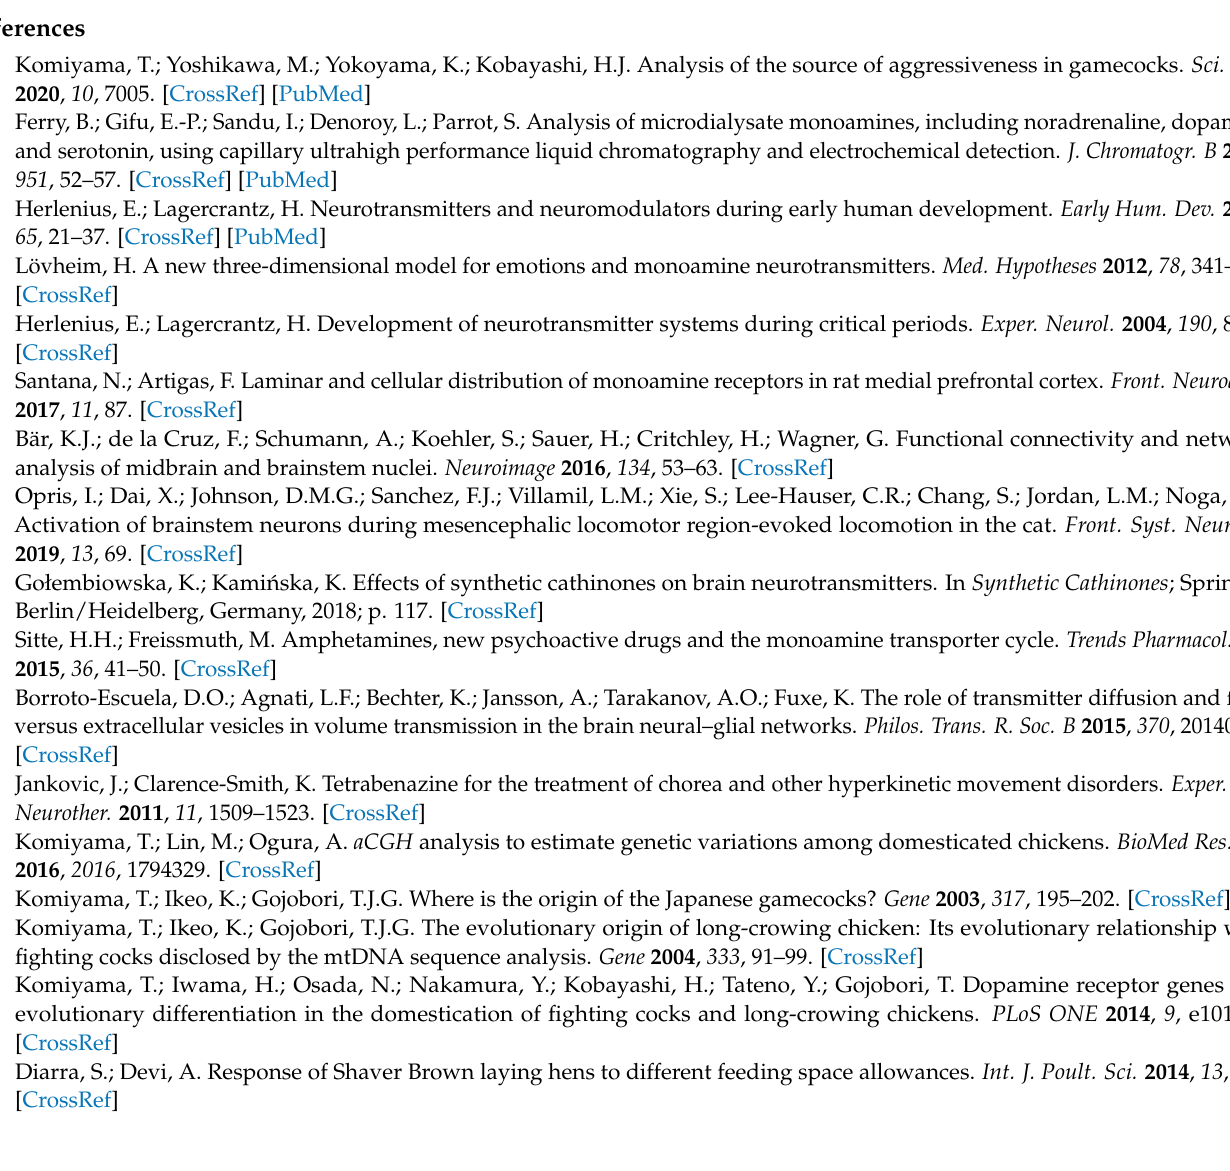
gene sequences; Table S2: Accession number of nine adrenergic receptors of wild birds; Table S3: DNA and amino acid mutation sites of ADR genes from breeds; Table S4. Protein subcellular localization prediction of nine ADR genes; Table S5: Prediction of transmembrane helices in proteins of nine ADR genes; Table S6: N ST population analysis data of ADRA1A ; Table S7: N ST population analysis data of ADRA1B ; Table S8: N ST population analysis data of ADRA1D ; Table S9: N ST population analysis data of ADRA2A ; Table S10: N ST population analysis data of ADRA2B ; Table S11: N ST population analysis data of ADRB1 ; Table S12: N ST population analysis data of ADRB2